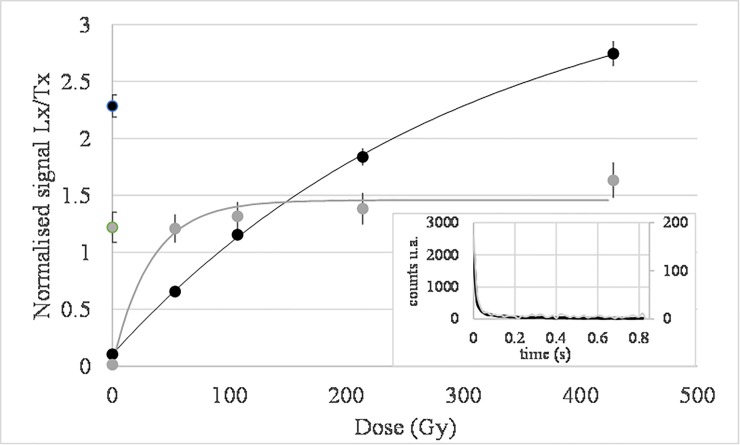
Example of two typical growth curves of BRS3 quartz grains: One (grey dots and curve) shows early saturation (D0 = 33 Gy) and is unable to allow measuring high De values, while the other one (black dots and curve) displays late saturation (D0 = 308 Gy) and can be used for measuring high De values.The inset shows corresponding natural glow curves (right axis for the black curve, left axis for the grey curve).